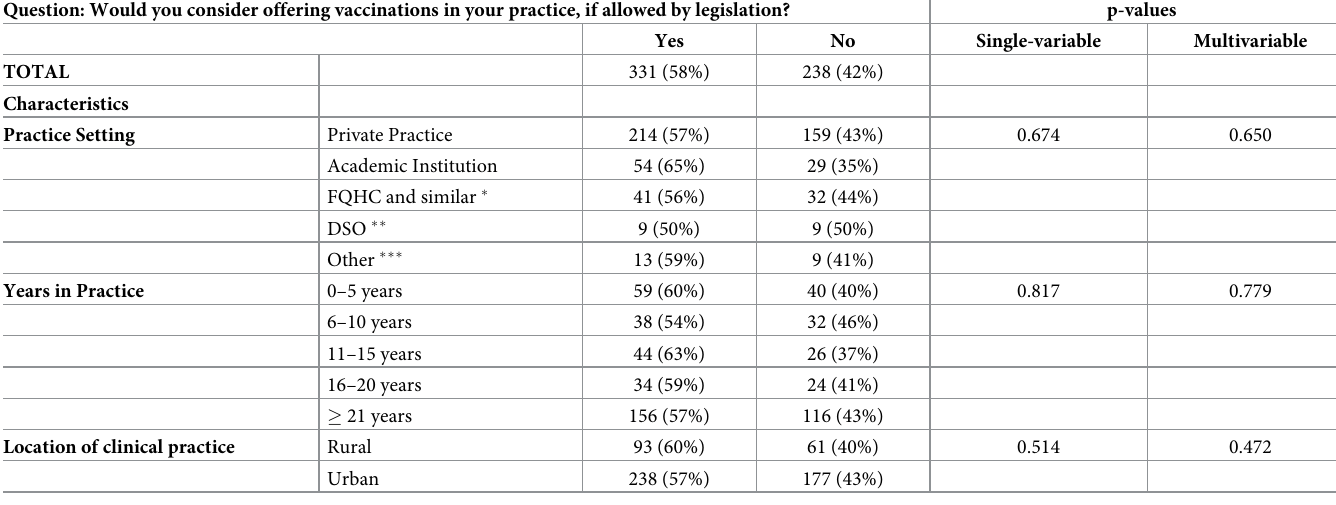
Table 3. Association of participant characteristics and vaccinations.